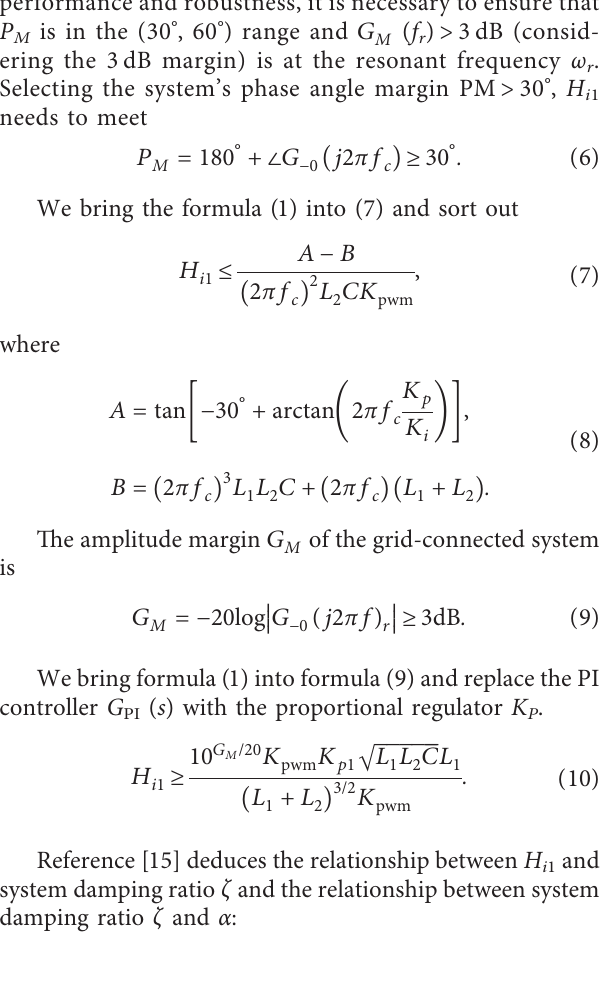
Figure 5: Under the different K inner Bode